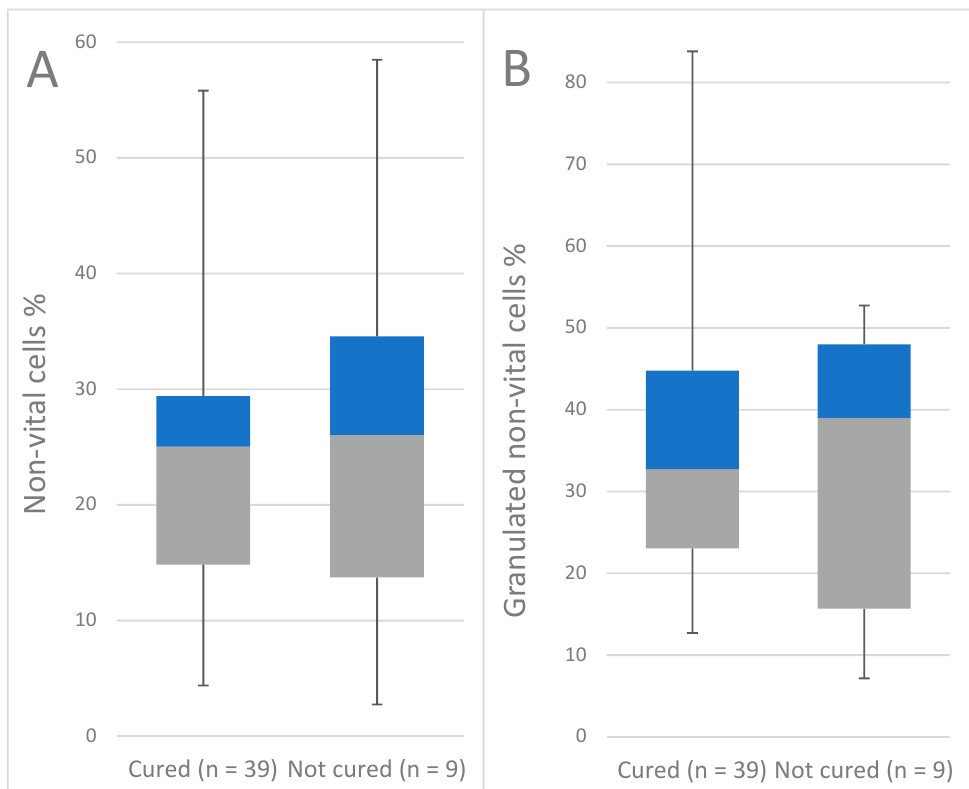
Figure 3. Box and whiskers plot of flow cytometric results of composite milk samples associated with the individual bacteriological cure: ( A ) percentage of non ‐ vital cells and ( B ) percentage of highly granulated non ‐ vital cells .